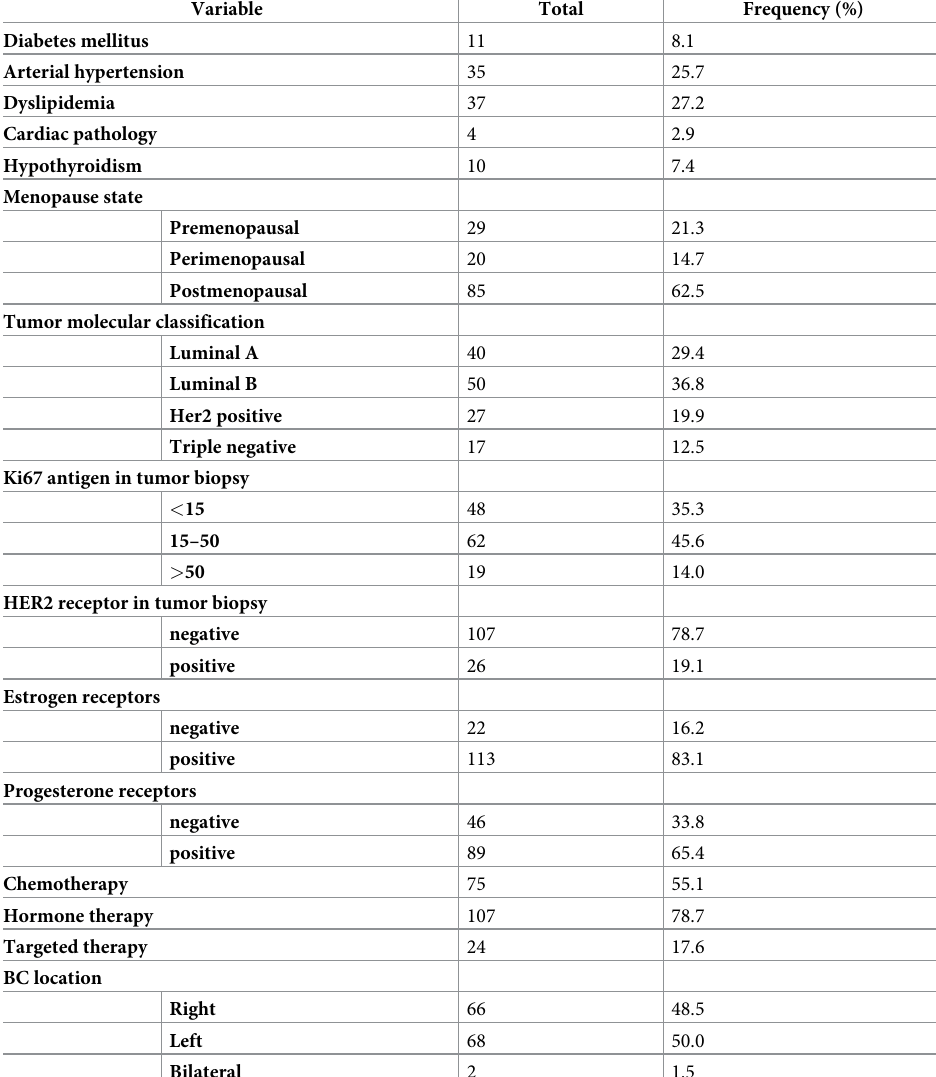
Table 1. Characteristics of BC